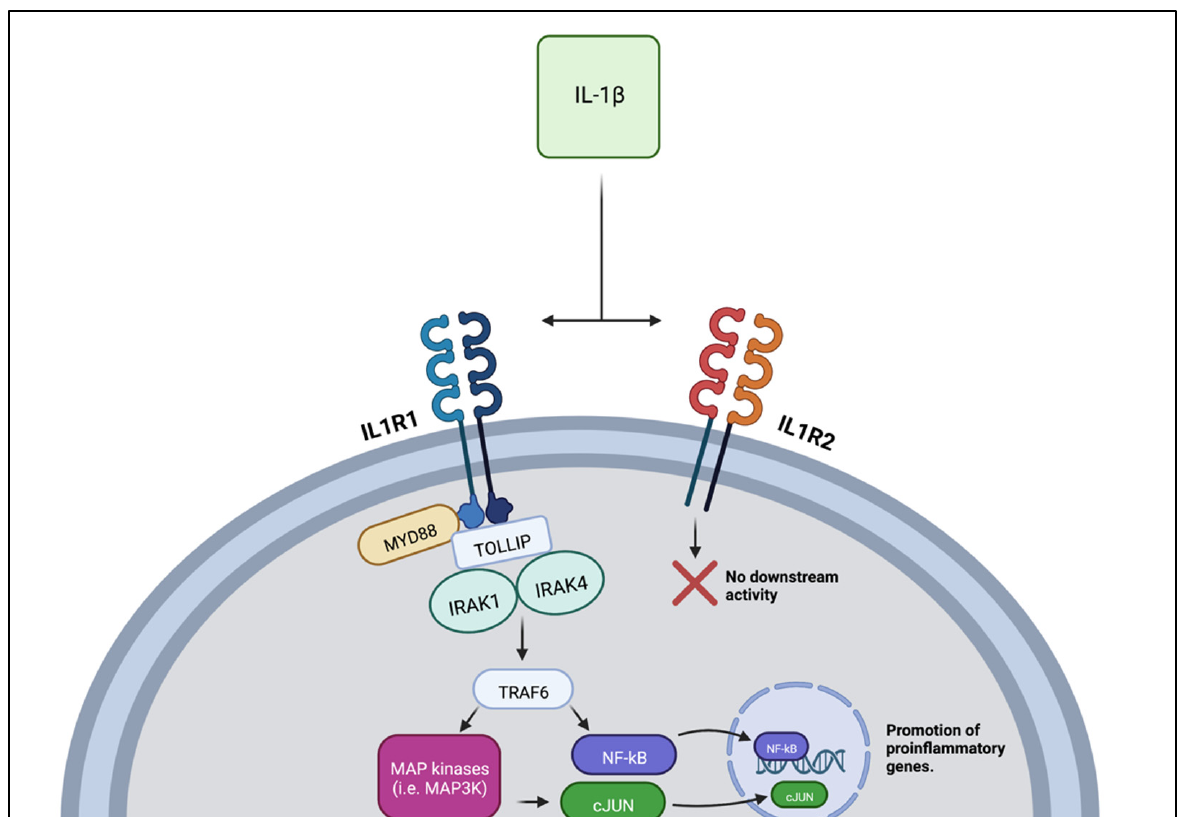
Figure 3. IL-1 β activity at the IL1R1 vs. IL1R2 receptors. Activation of the IL1R1 receptor results in pro-inflammatory and pyrogenic activity via activation of transcription factors and protein kinases. The IL1R2 receptor is a decoy receptor with no downstream biological activity.